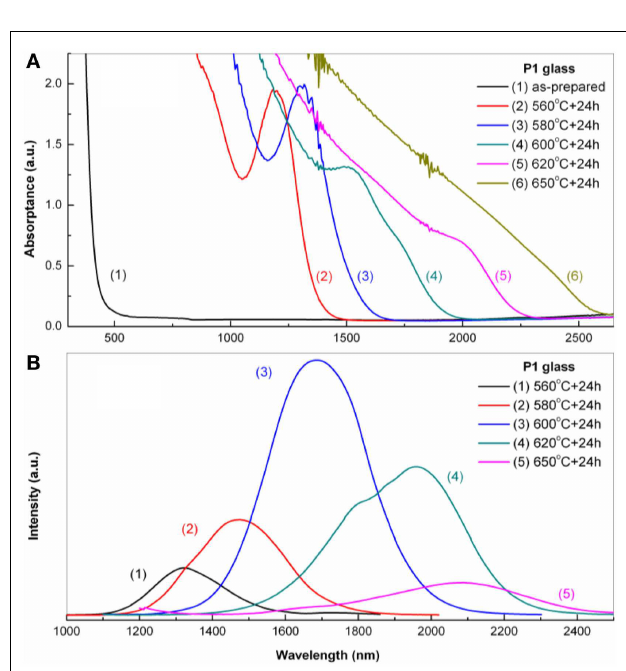
FIGURE 5 | (A) Absorption and (B) PL spectra of P1 glass heated at different temperature for 24h (Guoping et al., 2011; Huang et al., in press).